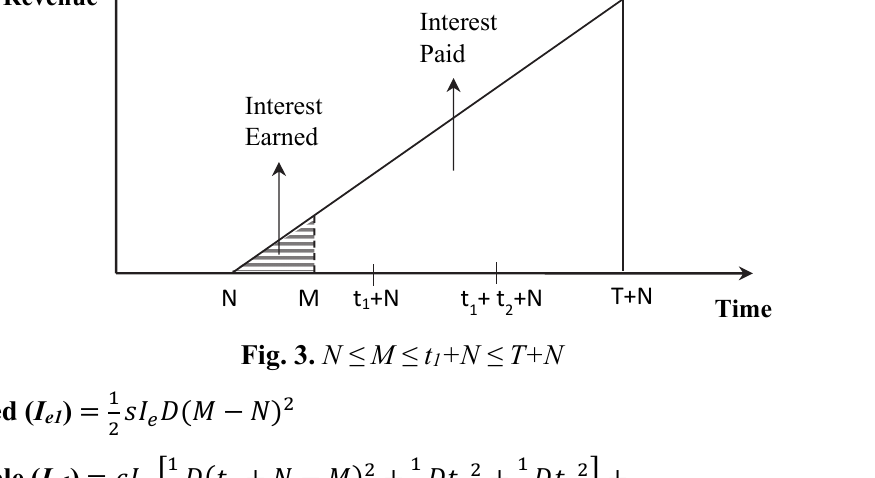
Fig. 3. N ≤ M ≤ t 1 +N ≤